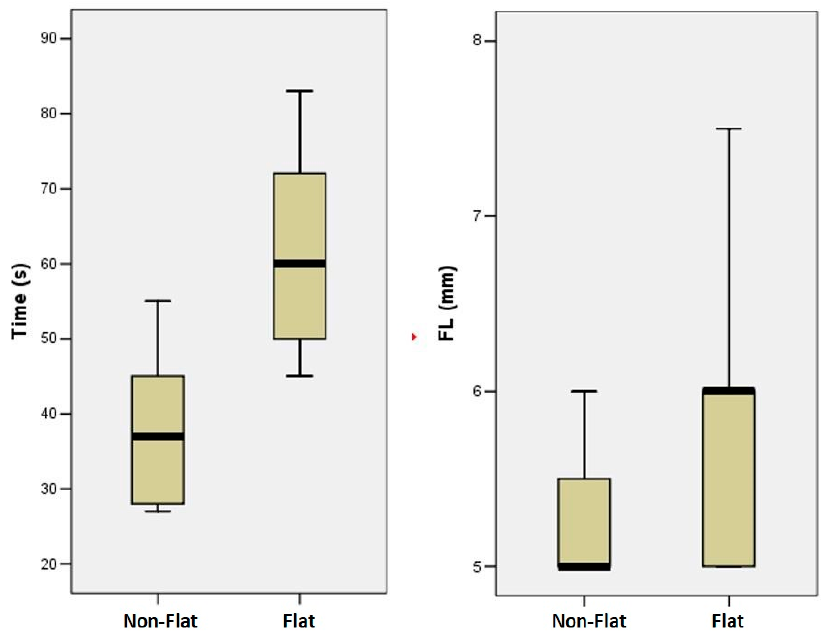
Figure 4. Di ff erences in terms of time to fracture and length of the fractured segment between Figure 4. Differences in terms of time to fracture and length of the fractured segment instruments. Box plots representing the di ff erences between the two groups for each between instruments. Box plots representing the differences between the two groups for each aspect.